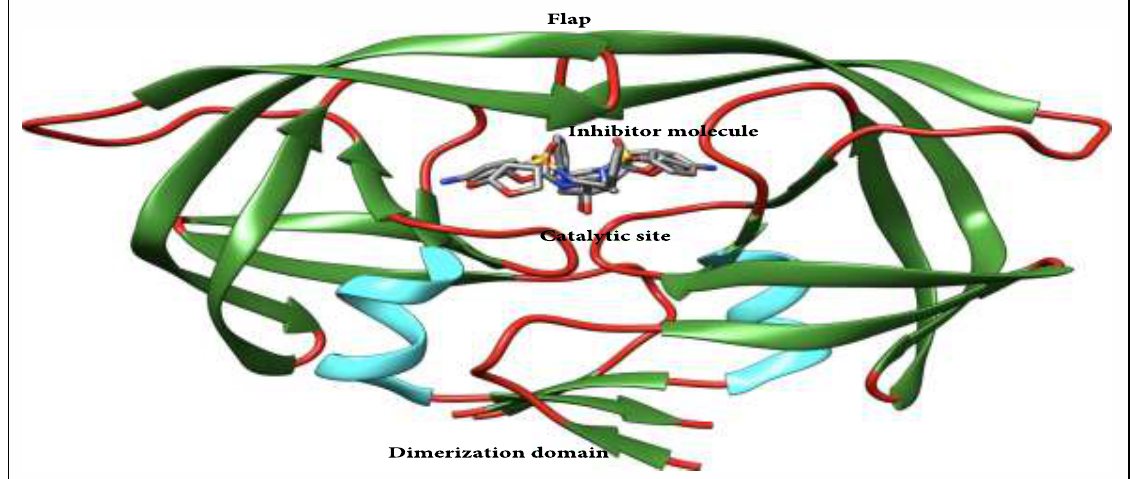
Figure 2. The crystal structure of the HIV-1 protease-inhibitor ligand complex (23)